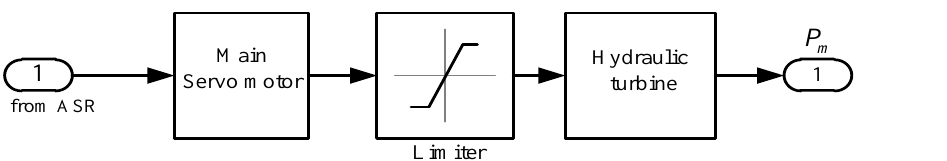
Figure 10. Simulink-model diagram for the hydraulic turbine unit in Figure 9.